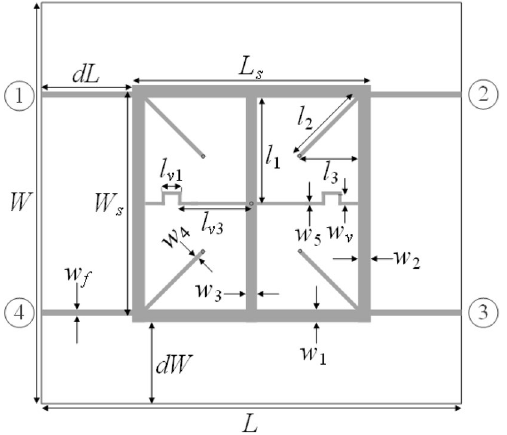
Figure 9. Dual-band branch-line coupler 56 ; circuit topology; port marked with numbers in circles.